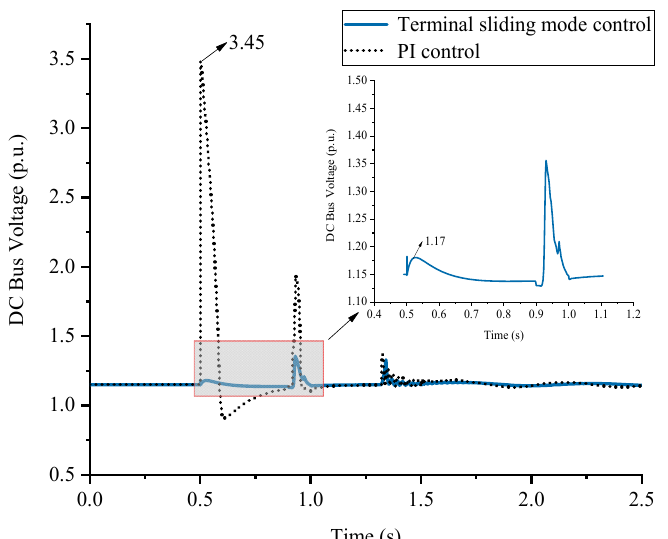
Figure 13. Comparison of the DC bus voltage under terminal sliding mode control and PI control.